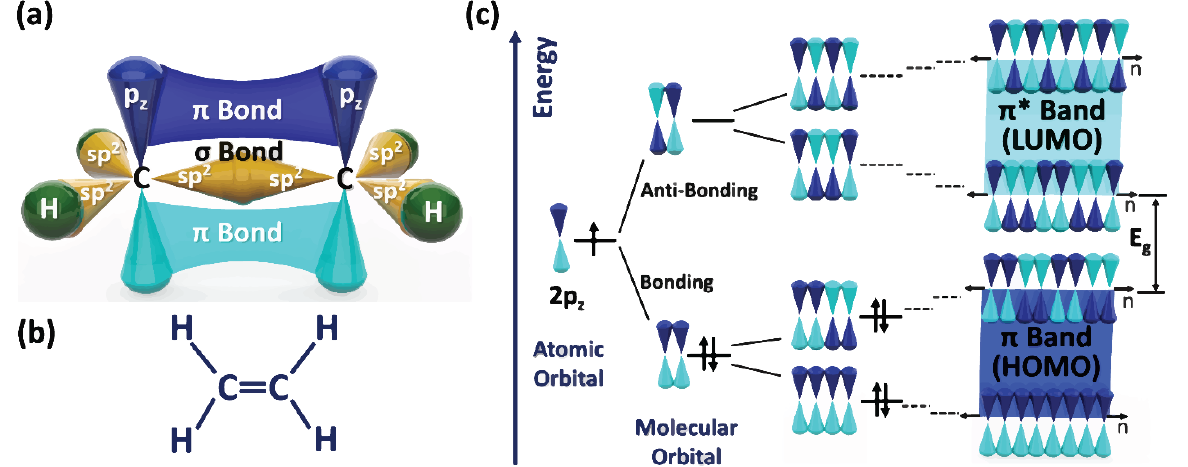
Figure 1. ( a ) Display of the sigma and pi bonds in conjugated polymers [1]. ( b ) The formal chemical structure of ethylene (CH2=CH2) [1]. ( c ) Display of bonding and anti ‐ bonding of 2pz orbitals at the atomic and molecular level [1]. The bonding and anti ‐ bonding mechanisms of 2pz orbitals yield to the filled and empty energy levels. ( a – c ) Reproduced with permission [1]. Copyright 2020, Elsevier.